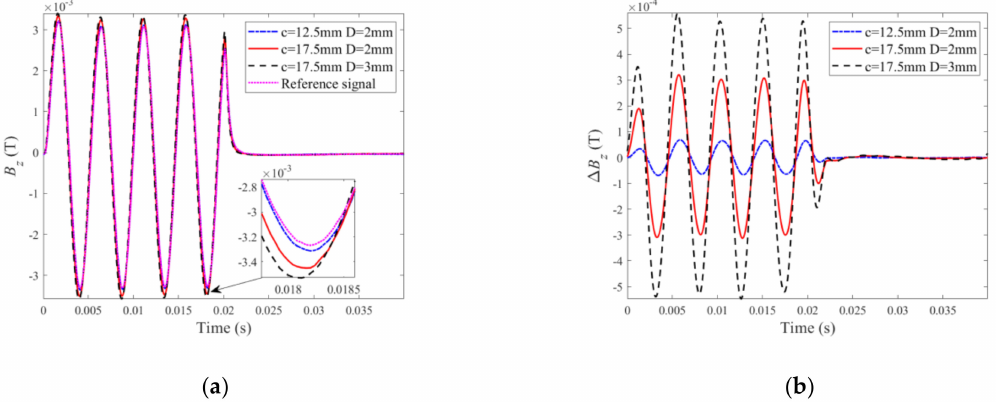
Figure 7. Experimental signals for different ILC parameters: ( a ) testing signals; ( b ) difference